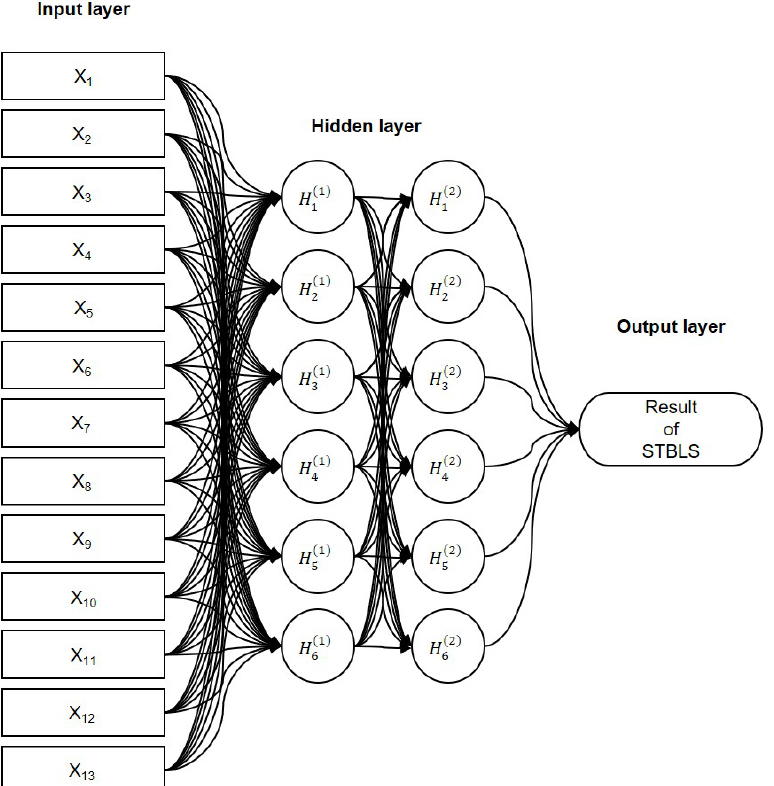
Figure 5. Combined Artificial Neural Network (ANN) for predicting STBLS score based on squat and one-leg standing measurement